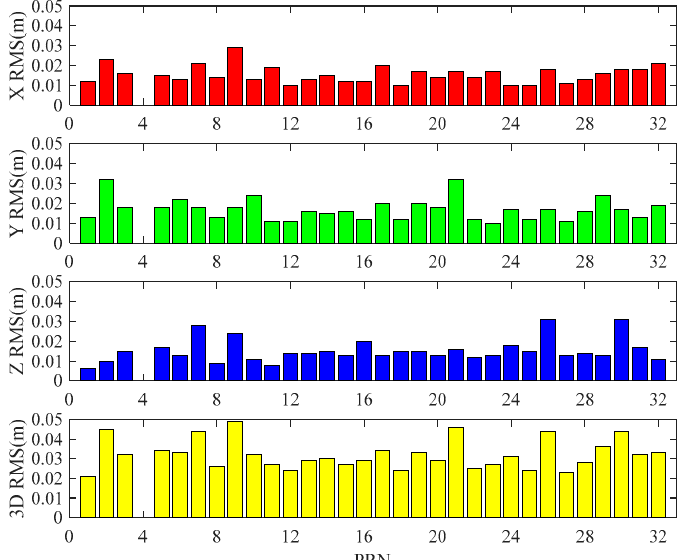
Figure 3. RMS values of corrected satellite orbit using RTS products in X, Y, Z directions and three-dimensional (3D) coordinates.